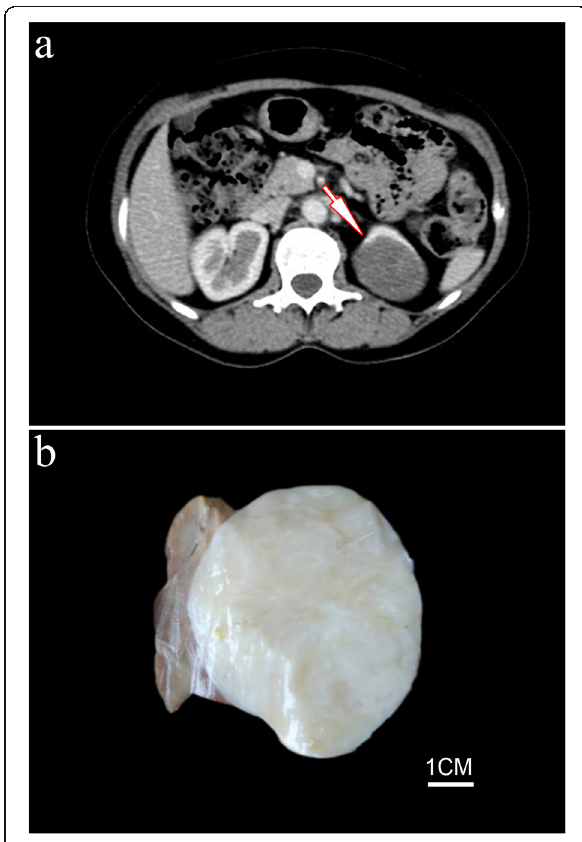
Fig. 1 Case 1. CT scan showed a sharply defined mass involving the upper pole of the left kidney ( A , as indicated by arrow ). Gross examination revealed a well-demarcated, round and whitish, solid tumor ( B